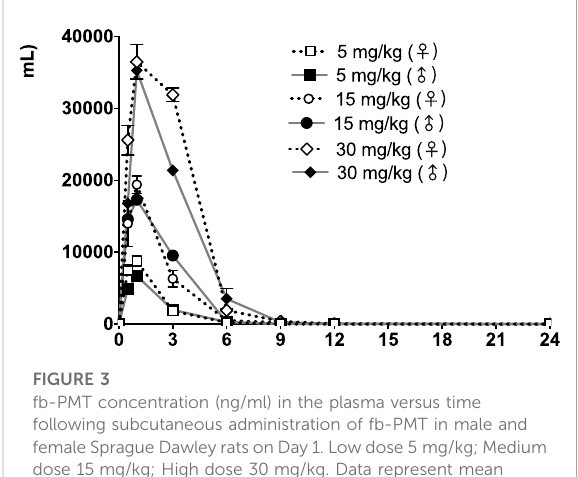
FIGURE 4 fb-PMT concentration (ng/ml) in the plasma versus time following subcutaneous administration of fb-PMT in male and female Sprague Dawley rats on Day 28. Low dose 5 mg/kg;